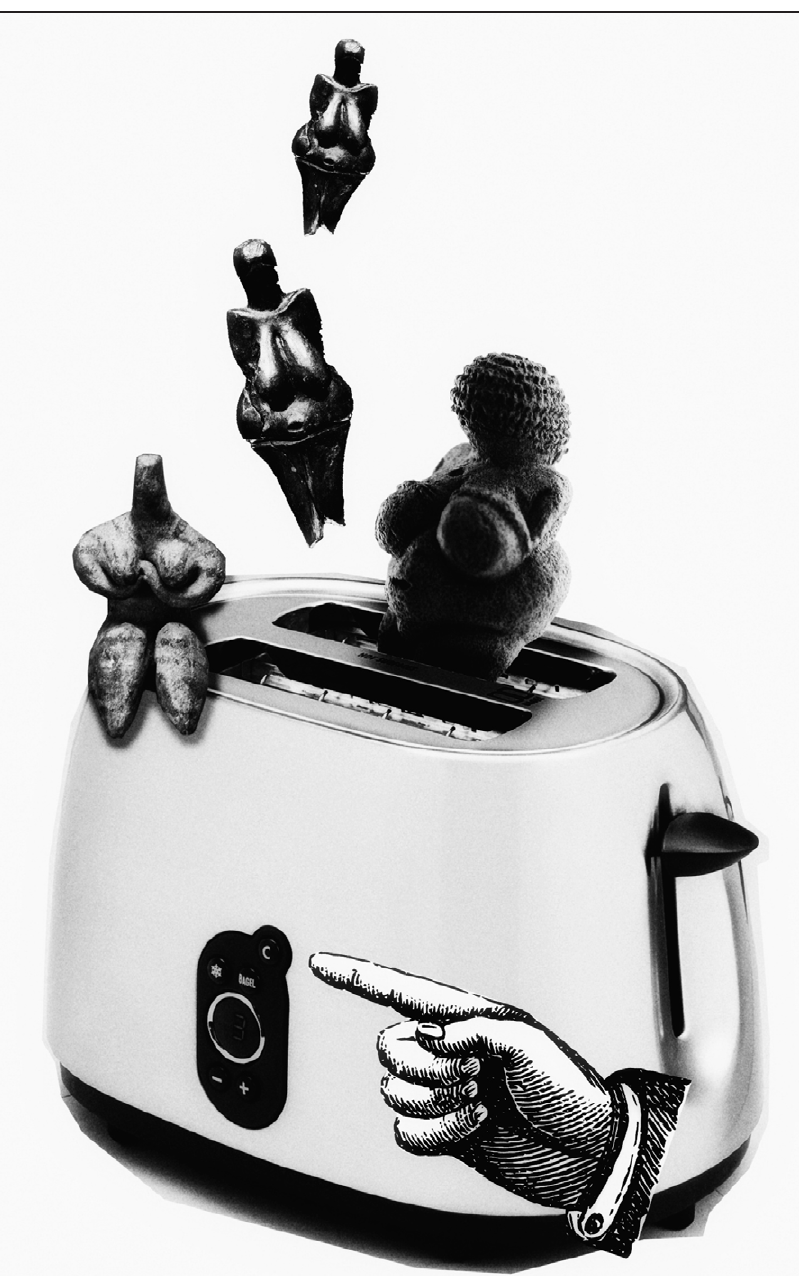
Figure 1: Are “smart” appliances a civilian trickle-down effect of the high-tech Gulf